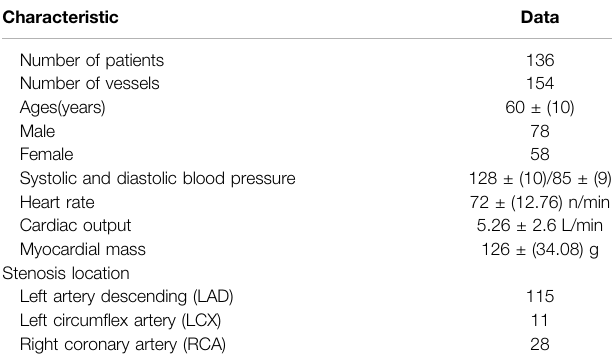
Frontiers in Physiology |